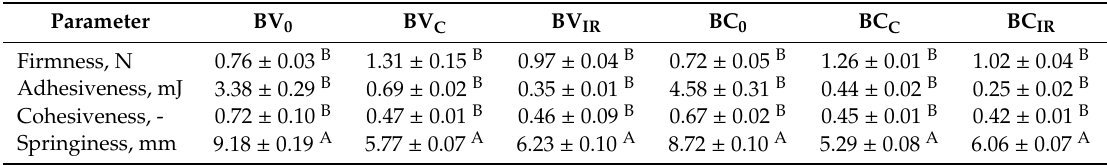
Table 3. The values of textural parameters.